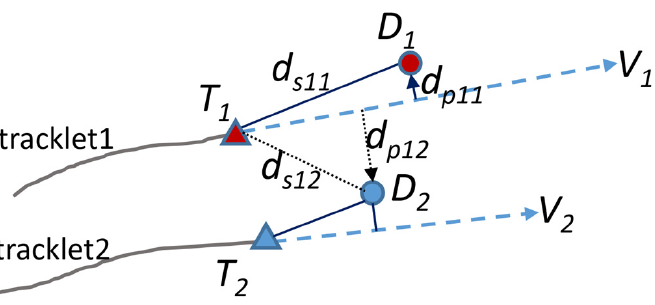
Figure 3. Distance measurement between targets and detections. d s11 and d s12 are the spatial distance from T 1 to D 1 and D 2 , respectively. d p 11 and d p 12 are the directional distance from line V 1 to D 1 and D 2 , respectively.